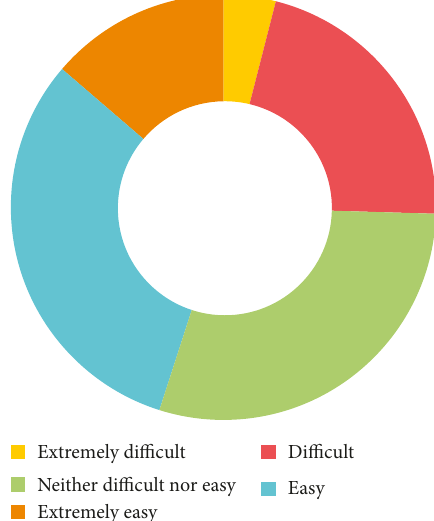
Figure 5: Visual representations of percentages of responses in Question